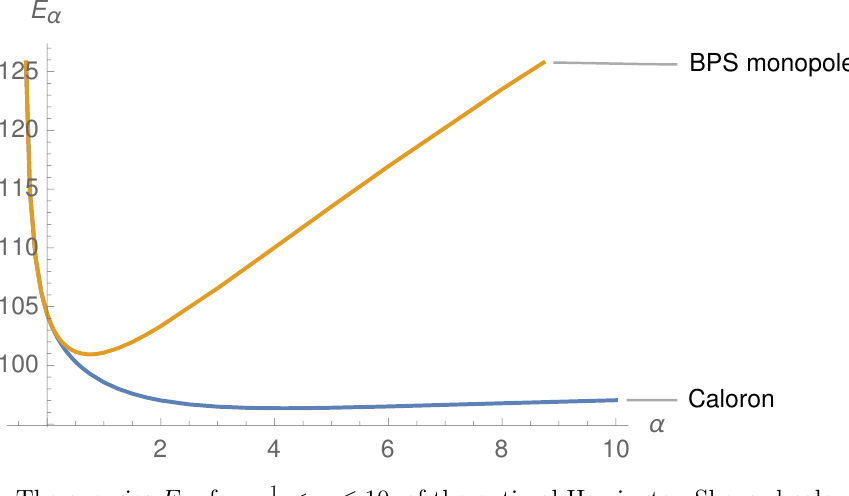
< (cid:11) (cid:20) 10, of the optimal Harrington-Shepard caloron and the 2